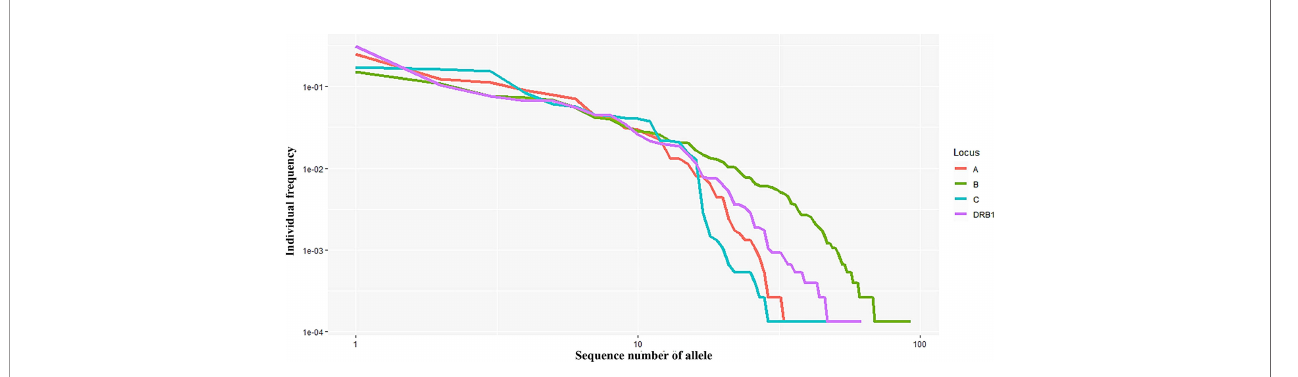
FIGURE 2 | Curves showing the allele frequency of each HLA locus (A, B, C, and DRB1) in descending order.Both the x - and y -axes are expressed on a logarithmic scale.